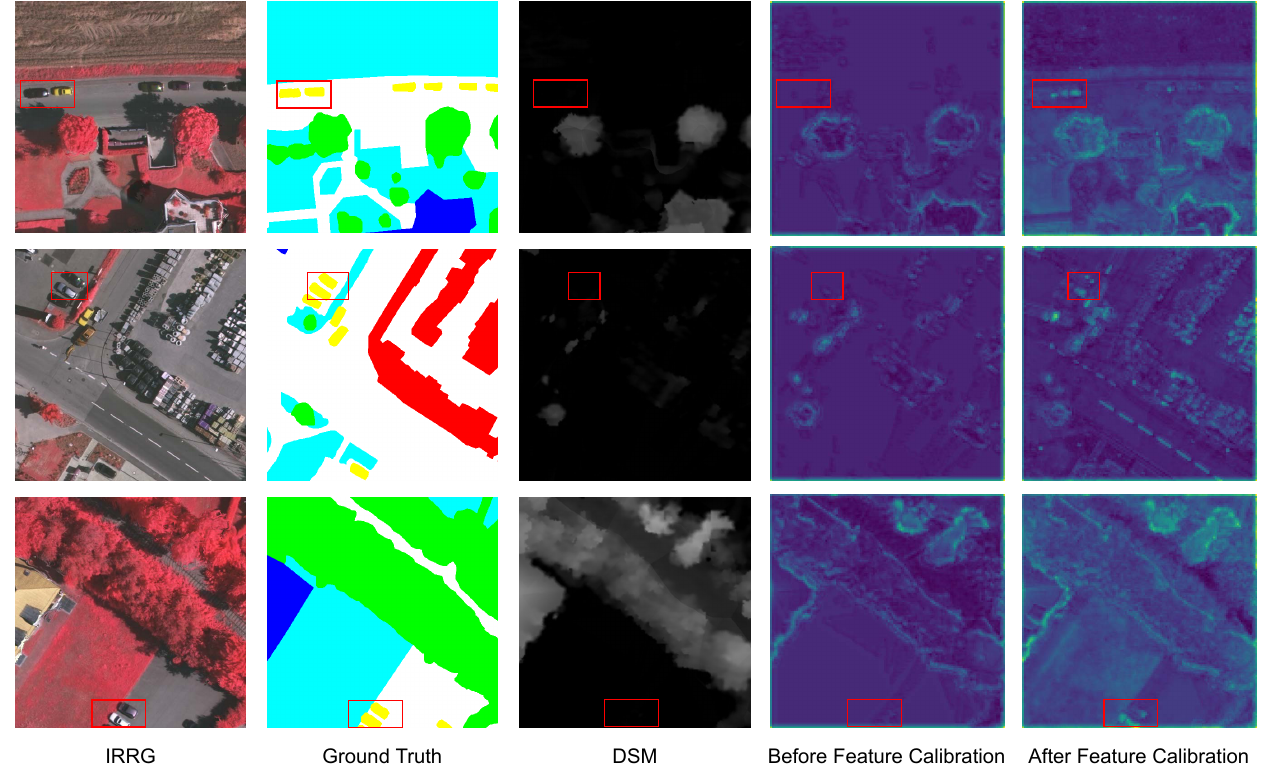
Figure 6. Visualization of Digital Surface Model (DSM) features before and after Feature Calibration